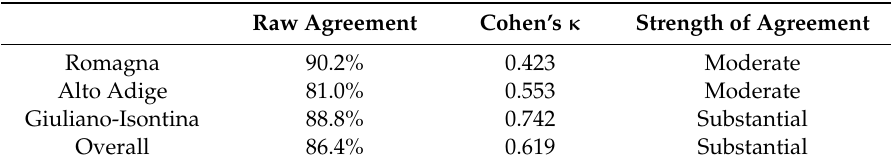
Table 3. Raw agreement and Cohen’s κ per